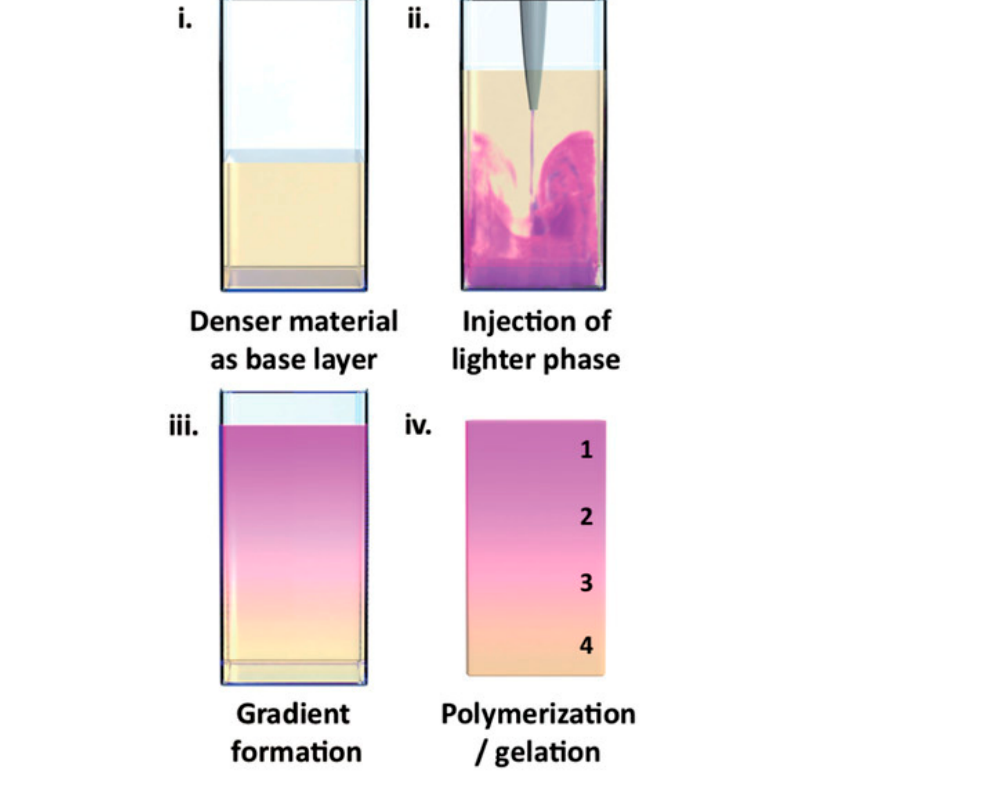
Figure 2. An example of gradient formation (the gradient is preserved by gelling or polymerizing the material) [13].